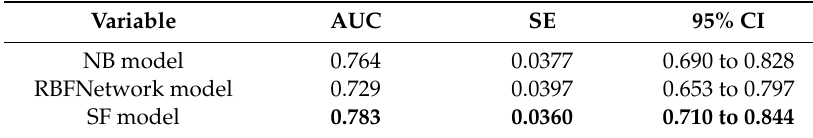
Figure 9. Modeling error in the training (a-c) and validation (d-f) datasets. 4.5. Comparison of Landslide Susceptibility Maps In this study, SF model was selected as the benchmark model, and the susceptibility maps generated by the other two models were matched with the susceptibility maps generated by the SF model using the method developed by Xiao et al. [82]. The difference between them is defined by subtraction in ArcGIS, as shown in Supplementary Figure 2. The raster values of the three susceptibility maps are between 0 and 1, so the value range of the comparison maps is (-1, 1). The three levels of underestimation, approximation and overestimation are based on the values obtained from the comparison map. Supplementary Table 1 shows the percentages of different levels in the total area. The values of both comparison maps break at -0.50 and 0.50. To obtain the key factors that cause differences between susceptibility maps, it is necessary to associate overestimated and underestimated pixels with all the adjustment factors used in the susceptibility analysis.